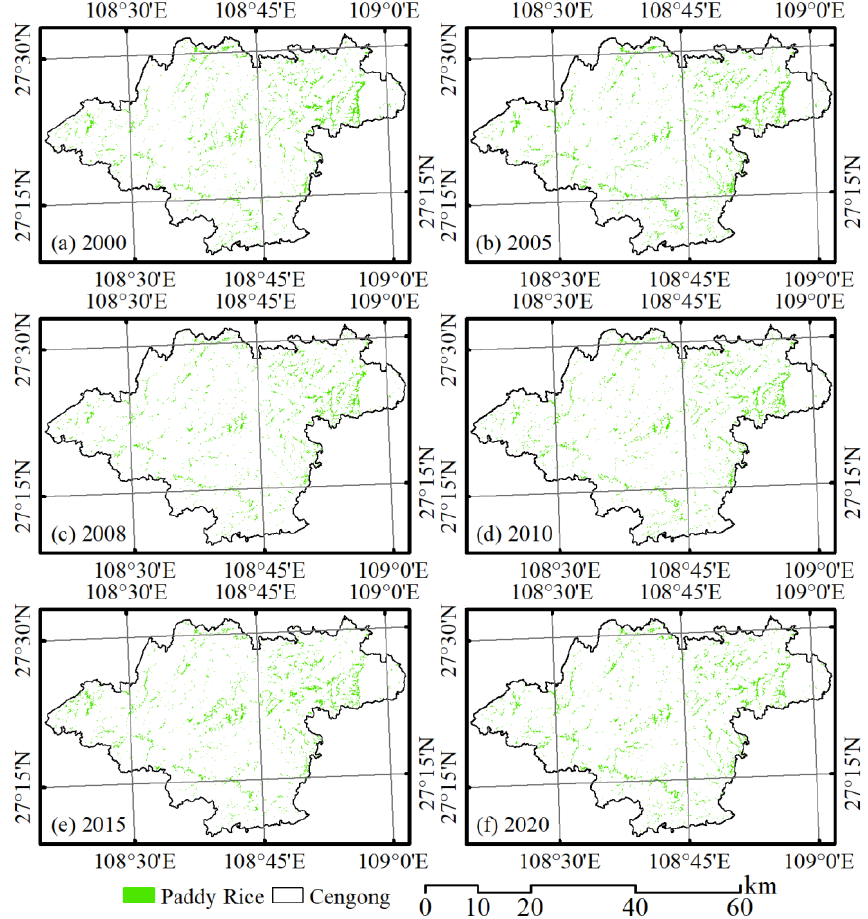
Figure 10. Paddy rice map generated by superpixel MLSTM-FCN in Cengong during 2000 – 2020. ( a ) 2000, ( b ) 2005, ( c ) 2008, ( d ) 2010, ( e ) 2015, and ( f ) 2020.